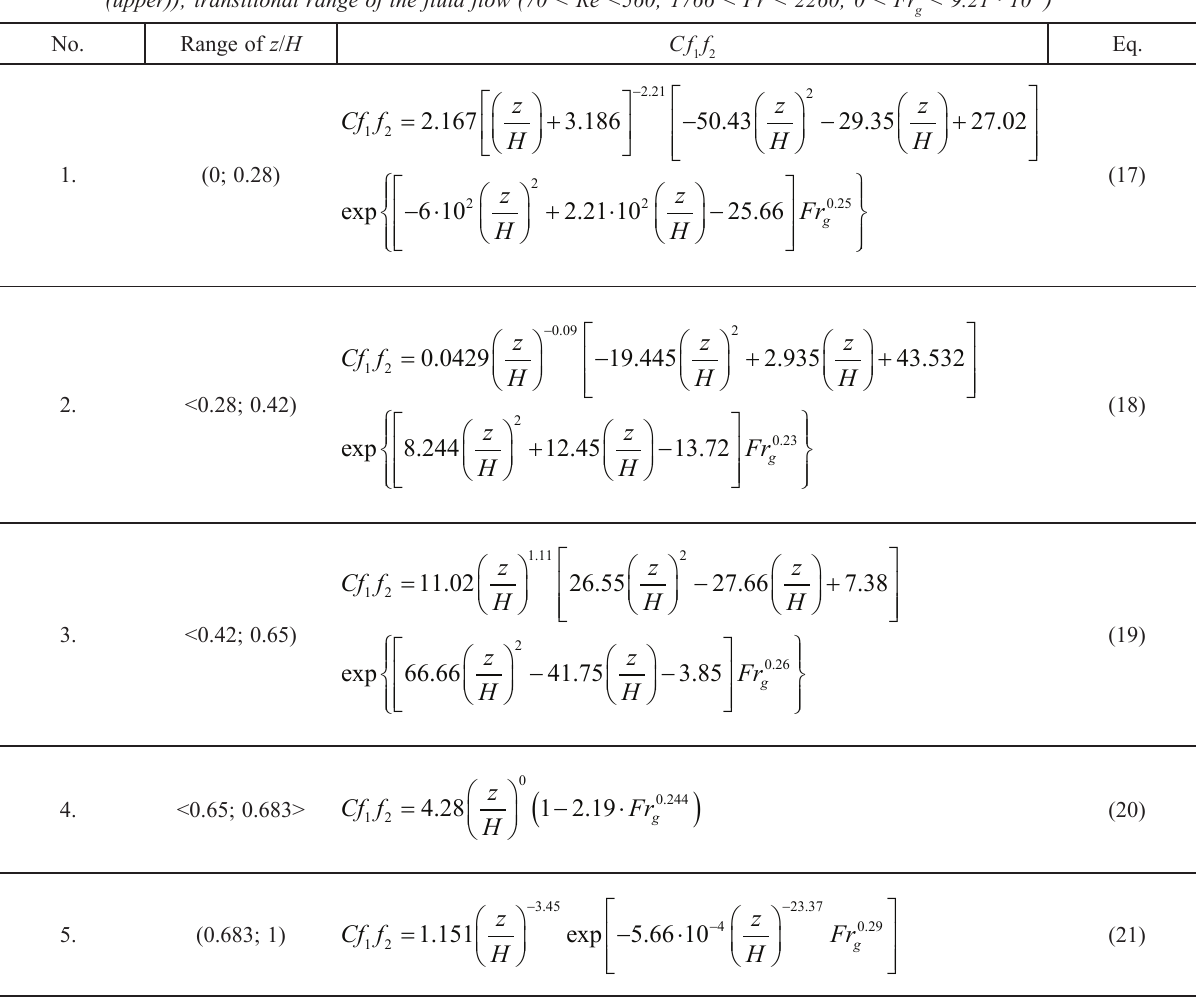
< 9.21 · 10 –5 ) g Eq. f 1 2